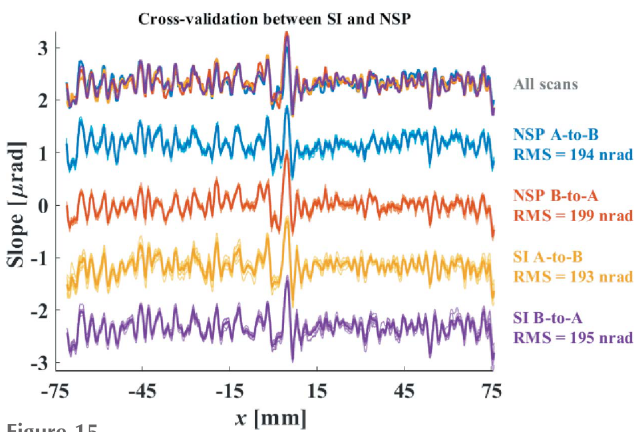
Figure 15 Cross-validation between the SI and NSP measurements of the residual slope errors along the x